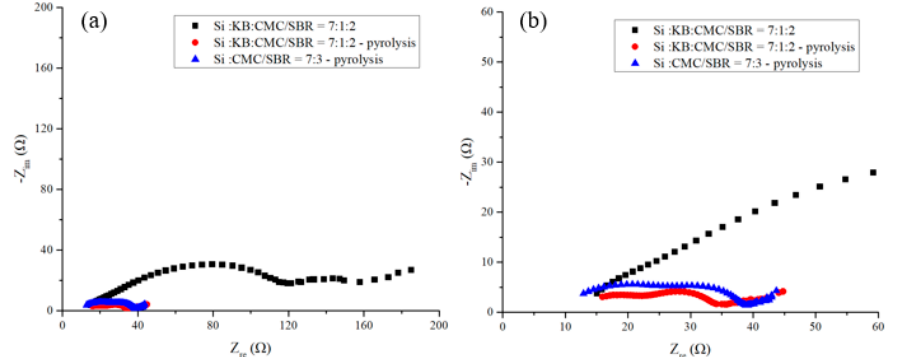
Figure 10. ( a ) and ( b ) Electrochemical impedance spectra measured from as fabricated anode and after 200 cycles of discharge/charge at 1000 mA/g for anode made of (black square) electrode with silicon flakes–KB–CMC/SBR = 70%:10%:20% in weight; (red dots) pyrolytic electrode with silicon flakes–KB–CMC/SBR = 70%:10%:20% in weight; (blue triangle) pyrolytic electrode with silicon flakes–CMC/SBR = 70%:30% in weight. ( b ) is an enlarged figure of ( a ).